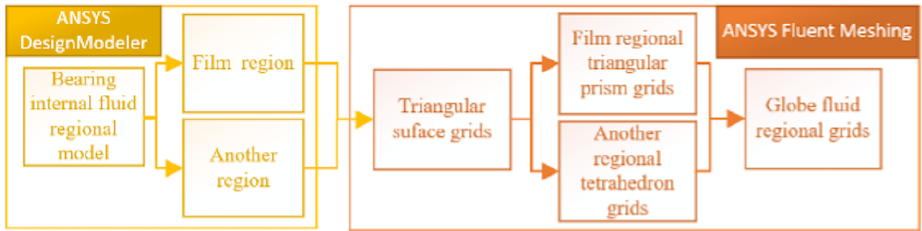
Figure 1. Flow chart for the generation of the global fluid domain mesh